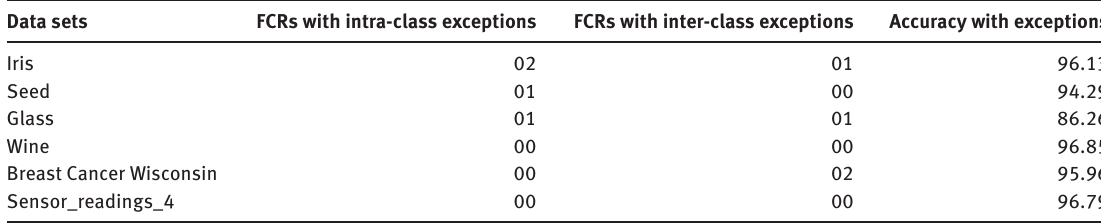
Table 9: Summary of FCRs Discovered with Exceptions. Data